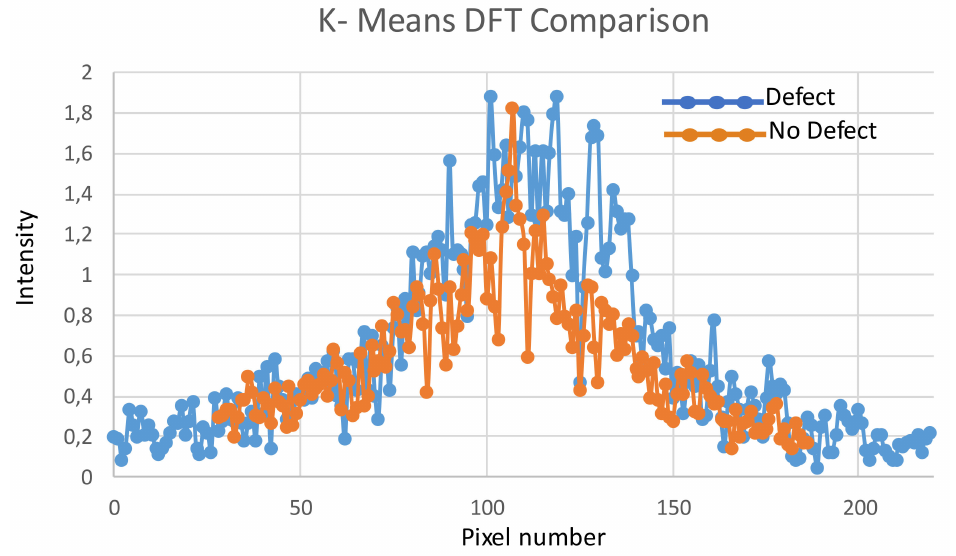
Figure 18. Comparison between the K-Means DFT amplitude spectrum of the K-Means image (K = 35) for defect and no defect region, respectively.